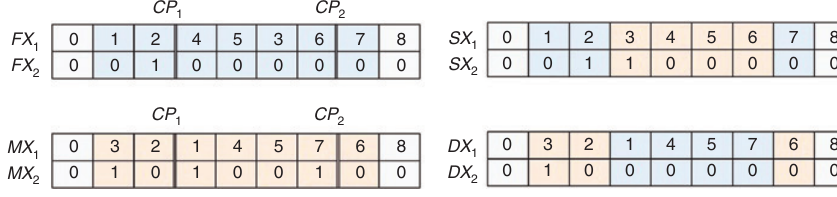
Figure 4: Two-Point Crossover.